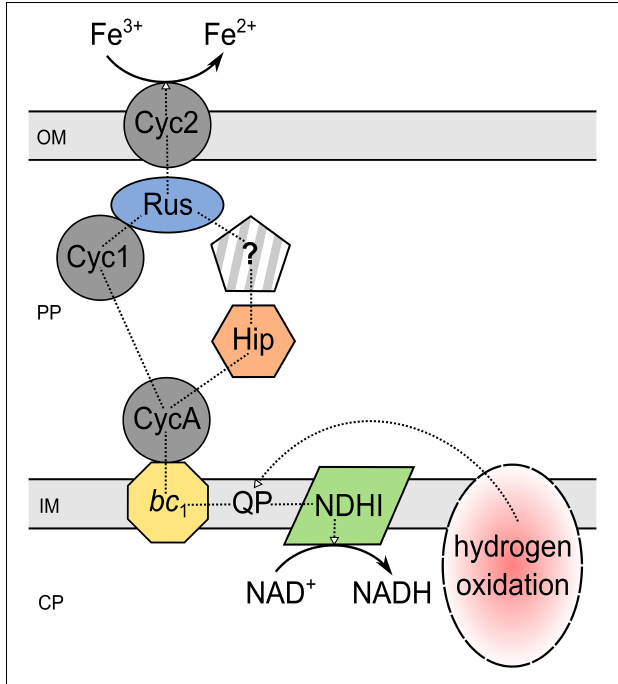
FIGURE 4 | Proposed mechanism of iron reduction coupled to hydrogen oxidation by Acidithiobacillus ferrooxidans . The underlying scheme is given in Kucera et al. (2020). PP, periplasm; CP, cytoplasm; OM, outer membrane; IM, inner membrane; Cyc, cytochrome c ; QP, quinol pool; Rus, rusticyanin; NDHI, NADH dehydrogenase complex; bc 1 , cytochrome bc 1 complex (encoded by petI/II ); Hip, high potential iron-sulfur protein; ?, unidentified pathway